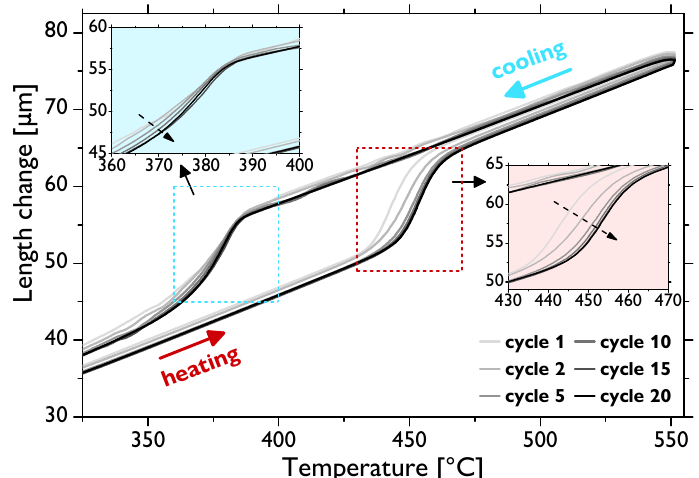
Figure 4. Selected thermodilatometric (TD) curves of the sample 1000 subjected to thermal cycling of 20 cycles.